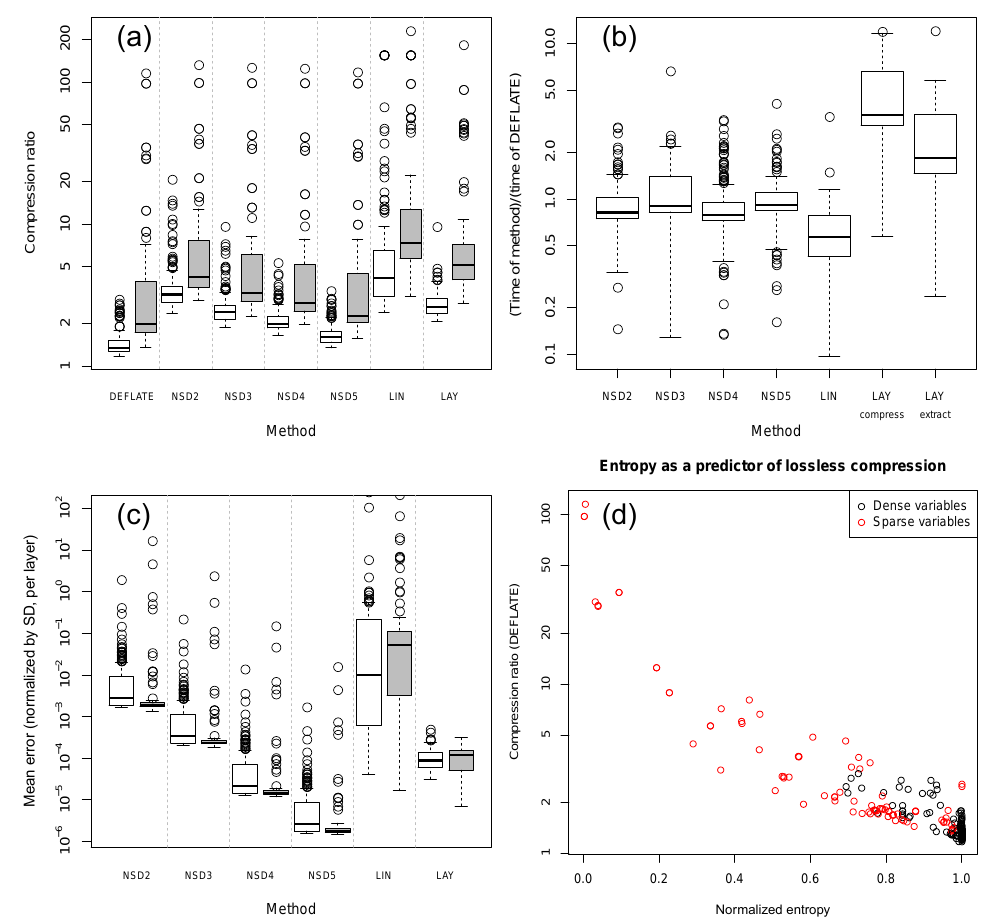
Figure 1. (a) Distribution of compression ratios (original file size divided by compressed file size) measured for seven methods, applied to six test data sets (higher is better), plotted separately by dense variables and sparse variables (white and grey boxes, respectively). The box plots (in panels a, b and c) were defined as follows: the thick line and the center of the box denotes the median, the bottom and top of the box show q 0 . 25 and q 0 . 75 (respectively) or the 0.25 and 0.75 quantiles of the distribution, the whiskers extend from q 0 . 25 − 1 . 5 · IQR to q 0 . 25 + 1 . 5 · IQR, where IQR is the inter-quartile range ( q 0 . 75 − q 0 . 25 ) and the points shown are all outliers beyond this range. (b) Distribution of scaled compression/decompression times for each method (lower is better), with LAY represented twice (for compression and extraction). These times are normalized by the compression time from DEFLATE. (c) Distribution of errors, normalized by the per-layer standard deviation. (d) The achieved lossless compression ratios (i.e., from DEFLATE) as a function of the normalized entropy (1.0 corresponding to the maximum theoretical for the